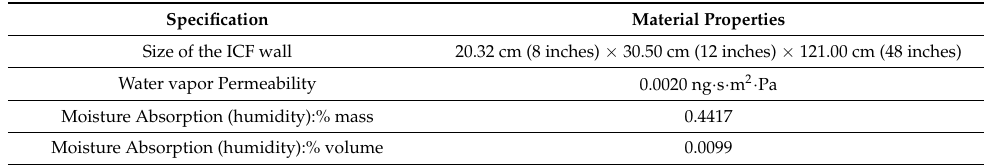
Table 2. Properties of the ICF